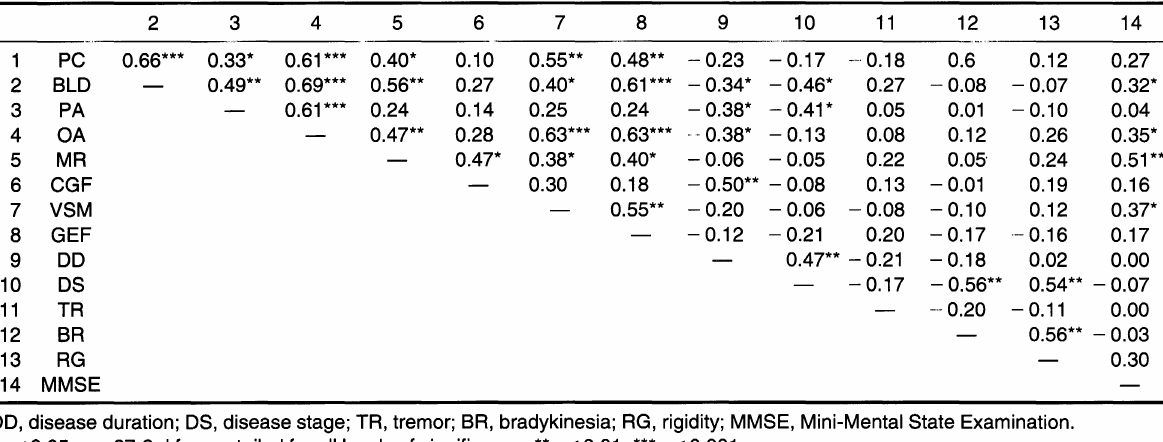
TABLE IX. Simple intercorrelations matrix of the eight psychological measurements and the clinical characteristics in PO patients (n c=